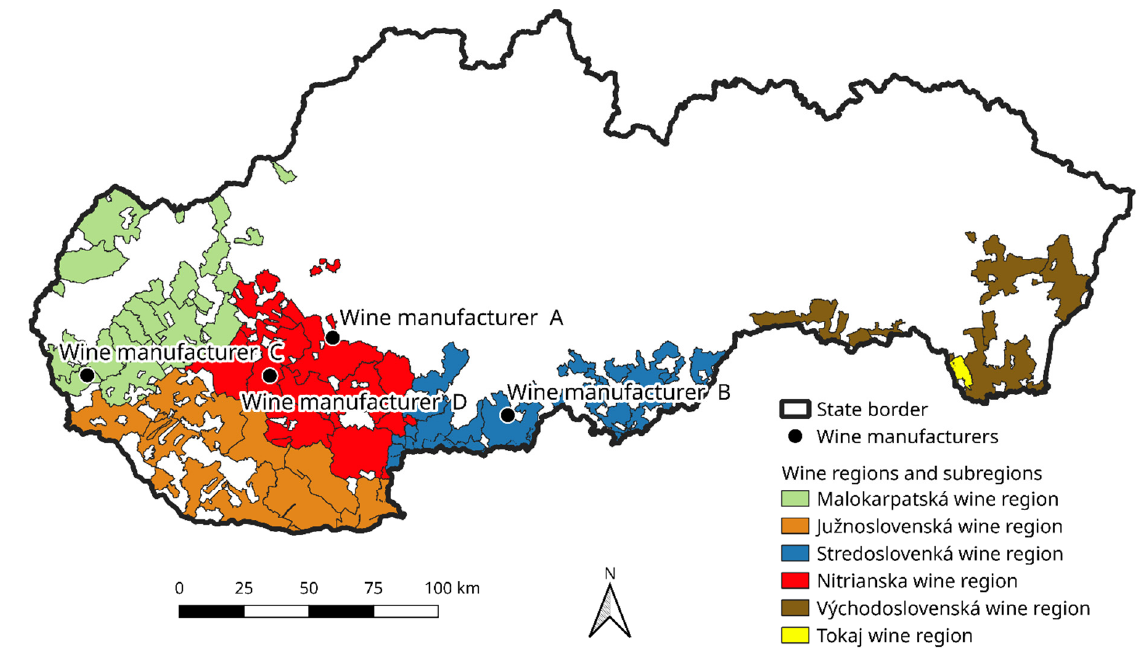
Figure 1. Location of wine